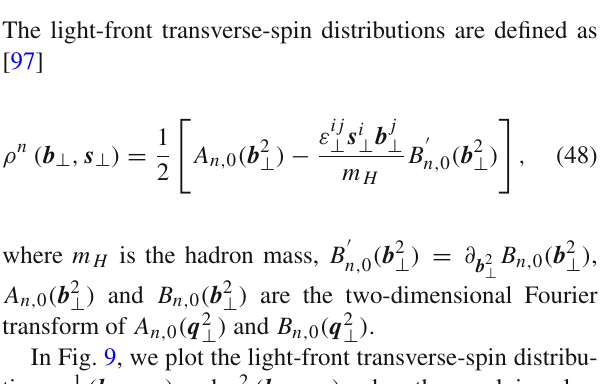
it is a definite value.